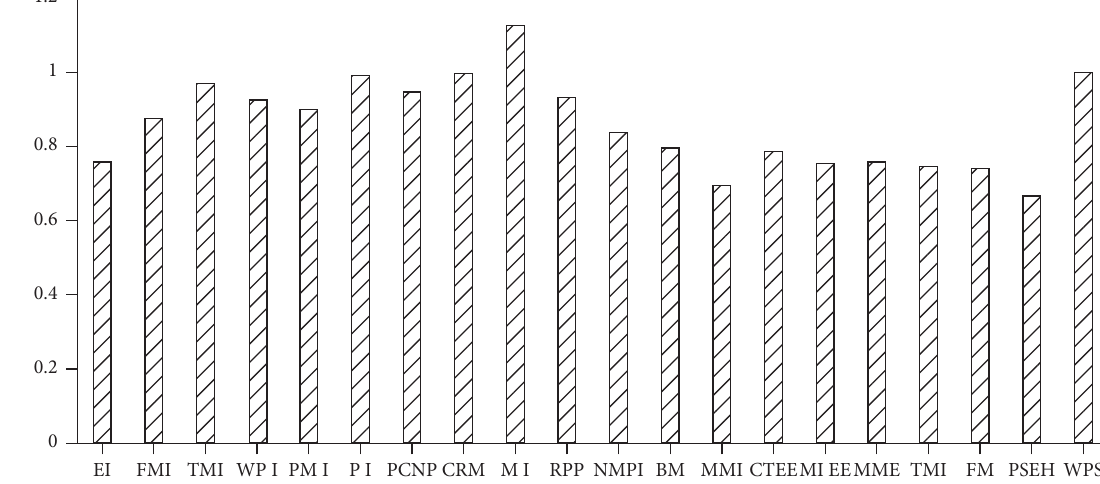
Figure 1: The ETFP growth index in China’s industrial sector,